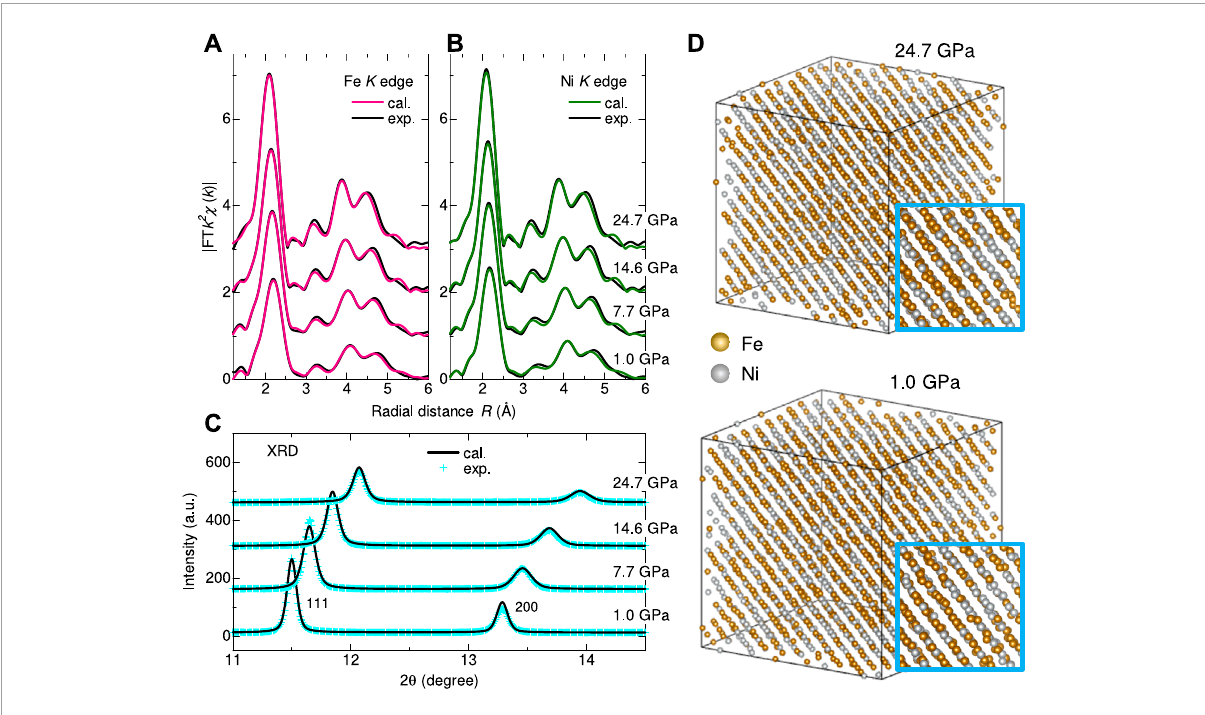
FIGURE 1 Comparison of the experimental profiles with fits by the RMC calculations. Absolute values of the | FT [ k 2 χ ( k ) ]| profiles of Fe 55 Ni 45 non-Invar at (A) Fe K -edge and (B) Ni K -edges. (C) X-ray diffraction patterns at selected pressures. (D) Atomic arrangements of the Fe 55 Ni 45 alloy obtained by the RMC calculation viewed from the [ 11 ̄ 2 ] direction. The insets show enlarged illustrations of the atomic clusters.